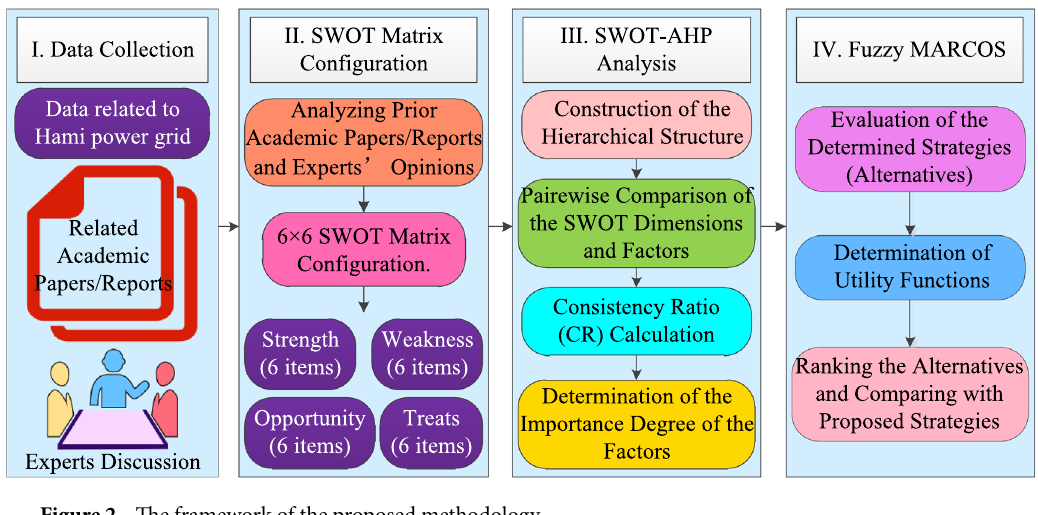
Figure 2. The framework of the proposed